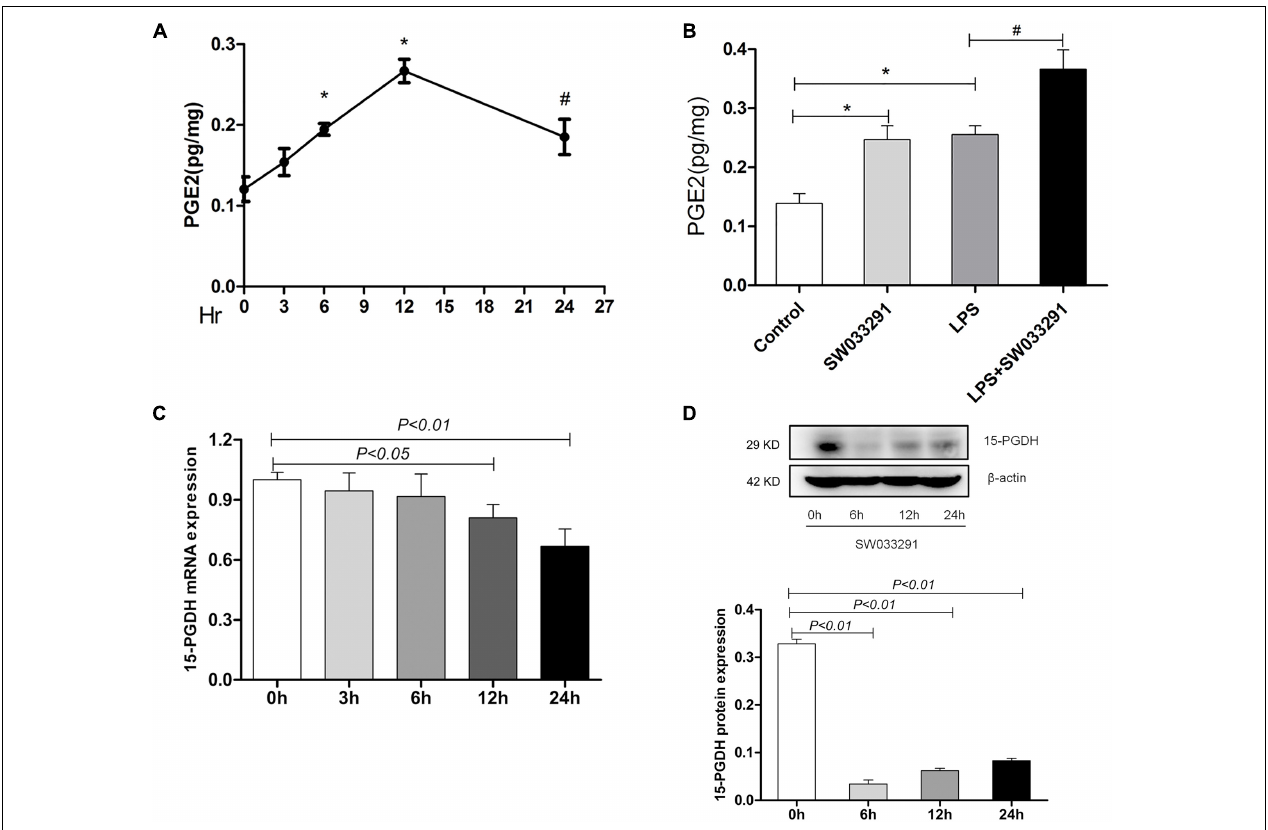
FIGURE 2 | Effect of SW033291 treatment on the blockade of 15-PGDH in the kidneys of mice. (A) Effect of SW033291 (10 mg/kg injected twice daily IP for five doses) treatment on renal PGE 2 content at 0, 3, 6, 12, and 24 h ( n = 6). * P < 0.01 vs. 0 h, # P < 0.05 vs. 0 h. (B) PGE 2 content in kidney tissue of mice induced by LPS (10 mg/kg) at 12 h ( n ≥ 6).* P < 0.01 vs. Control, # P < 0.05 vs. LPS. (C) Expression of 15-PGDH mRNA after SW033291 (10 mg/kg) treatment at different time points ( n = 3). (D) Expression of 15-PGDH protein after SW033291 (10 mg/kg) treatment at different time points ( n = 3). Data are mean ±